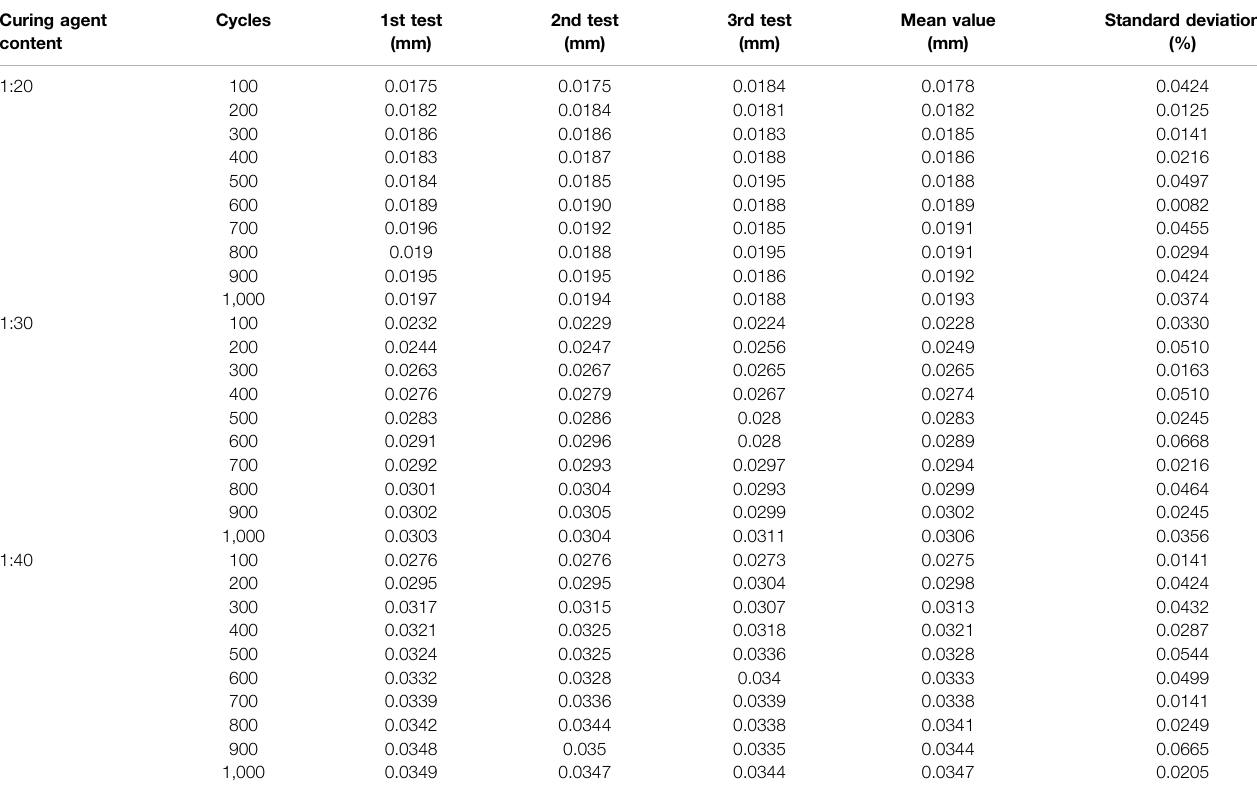
TABLE 3 | Cumulative strain change curve of different curing agent content under dynamic load. Curing agent